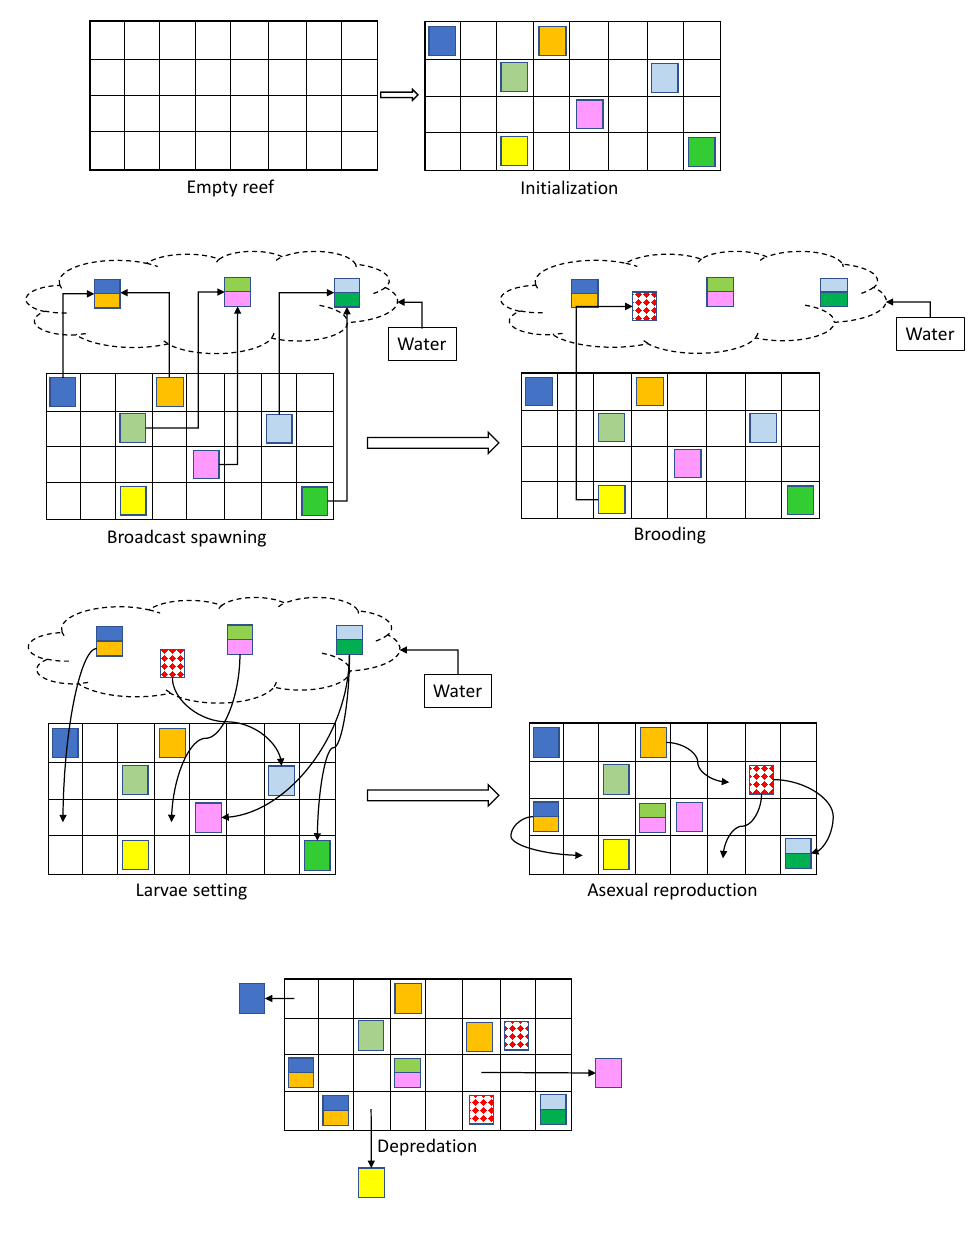
Figure 1. Phases of the basic CRO